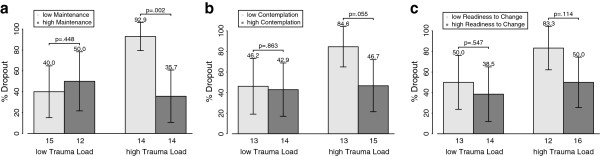
Dropout rates in groups of patients. We report treatment dropout in percent and 95% confidence intervals in the four groups with high and low Trauma Load divided by high and low motivation score. Numbers below columns represent numbers of subjects in the respective groups. A) Maintenance subscale. B) Contemplation subscale, C) RTC composite score.